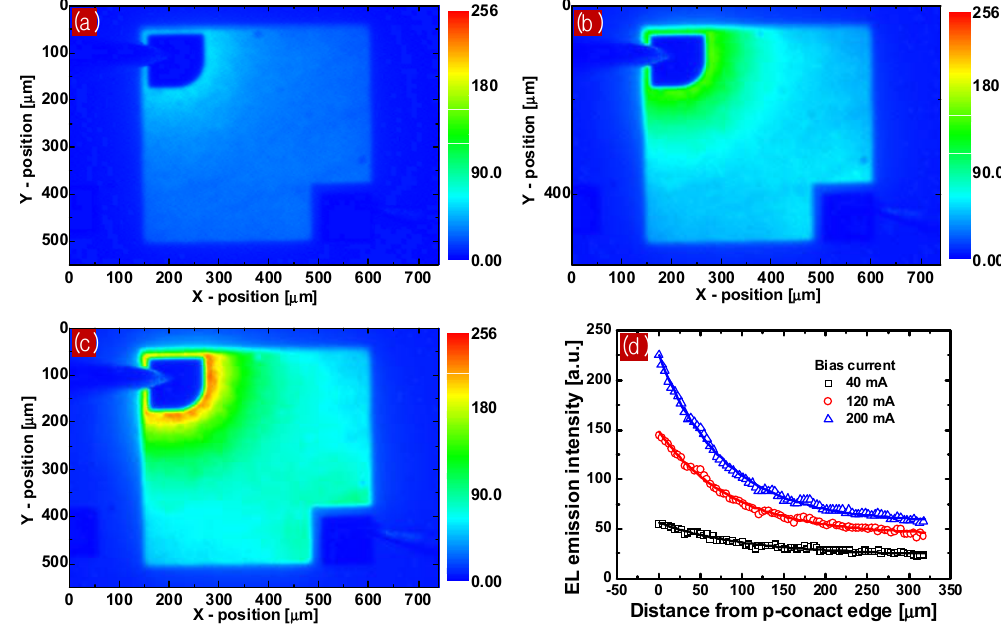
Figure 8. Electroluminescence (EL) intensity distribution on the LED surface with a cw bias current of ( a ) 40, ( b ) 120, and ( c ) 200 mA. ( d ) EL intensity vs. horizontal distance from the p-contact edge on the LED surface. Solid line is exponential decay